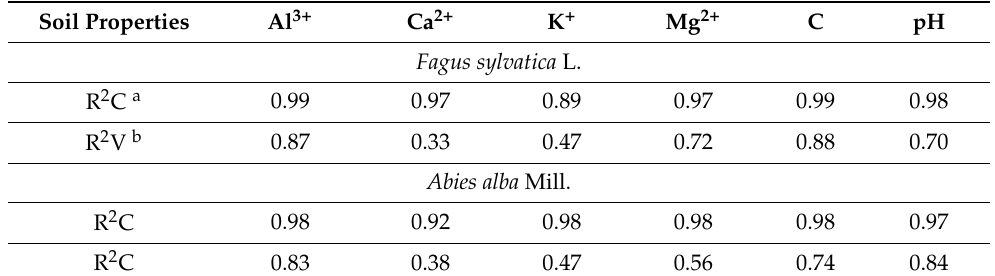
Figure 5. Calibration scatter plots of measured versus predicted values for ( a ) Al 3+, ( b ) Ca 2+ , ( c ) K + , ( d ) Mg 2+ , and ( e ) C contents, and ( f ) pH of soil under fir stands. Table 2. Results of calibration and validation (Al 3+ , Ca 2+ , K + , Mg 2+ , and C contents, and pH), expressed by R 2 C and R 2 V.